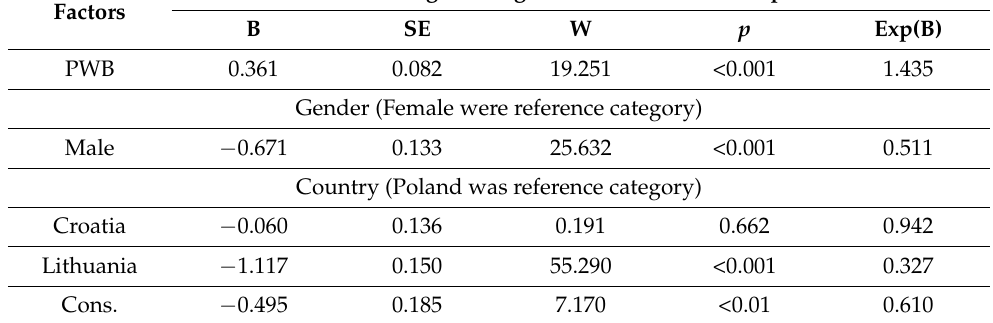
Table 4. Results of binomial logistic regression for the relationship between civic engagement (CE) during the COVID-19 outbreak in the experiences of Polish, Croatian, and Lithuanian students and factorial models, namely psychological well-being (PWB), gender, and country; B = coefficient; SE = standard error; W = Wald statistic; Exp(B) = the odds ratio. The Binomial Logistic Regression of CE and Multiple of Factors Factors B SE W p Exp(B) PWB 0.361 0.082 19.251 <0.001 1.435 Gender (Female were reference category) Male − 0.671 0.133 25.632 <0.001 0.511 Country (Poland was reference category) Croatia − 0.060 0.136 0.191 0.662 0.942 Lithuania − 1.117 0.150 55.290 <0.001 0.327 Cons. − 0.495 0.185 7.170 <0.01